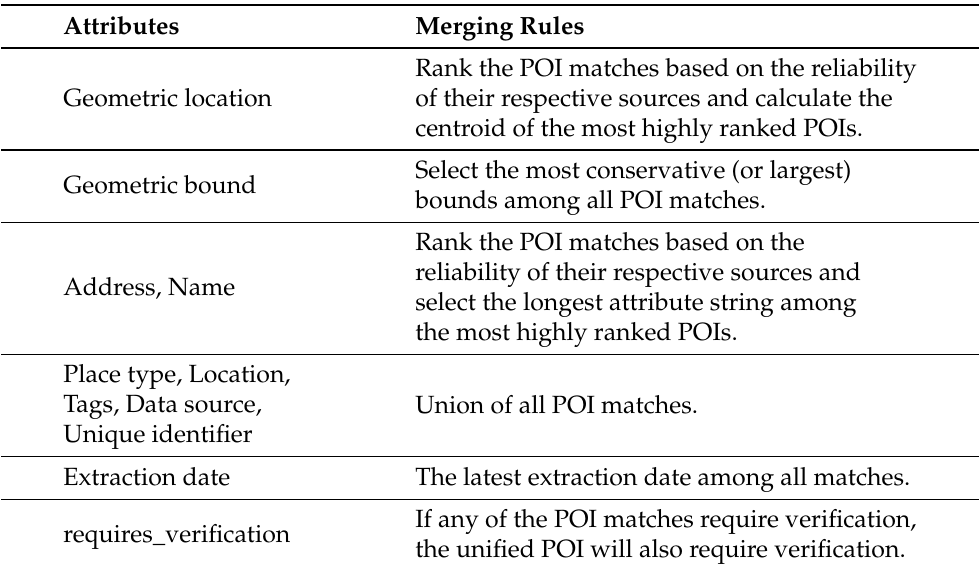
Table 3. Merging rules for POI